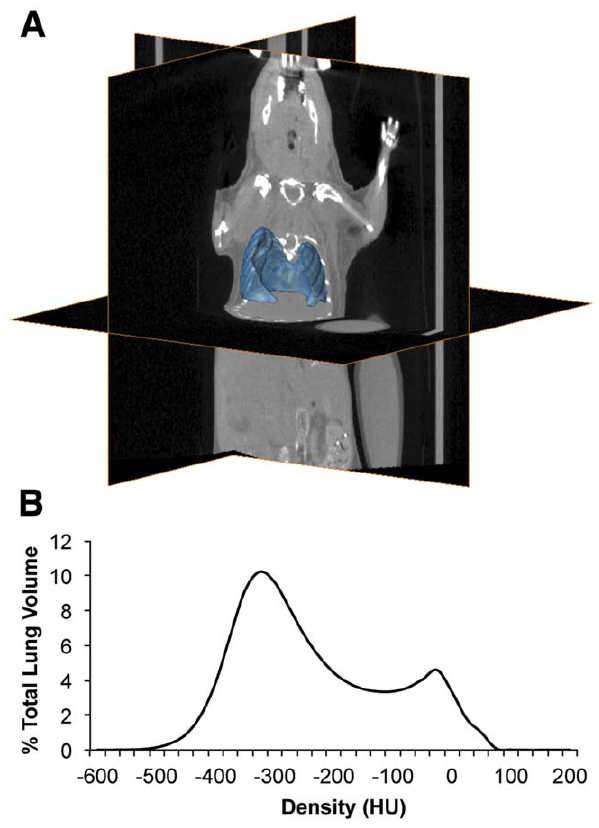
Figure 3. Lung segmentation used in the V/Q analysis. A Representative lung segmentation used in V/Q co-registration and analysis, with CT orthoslices for reference. B Average volume- standardized CT densitometry of ungated images in Hounsfield units (HU) depicting the distribution of densities within the label.